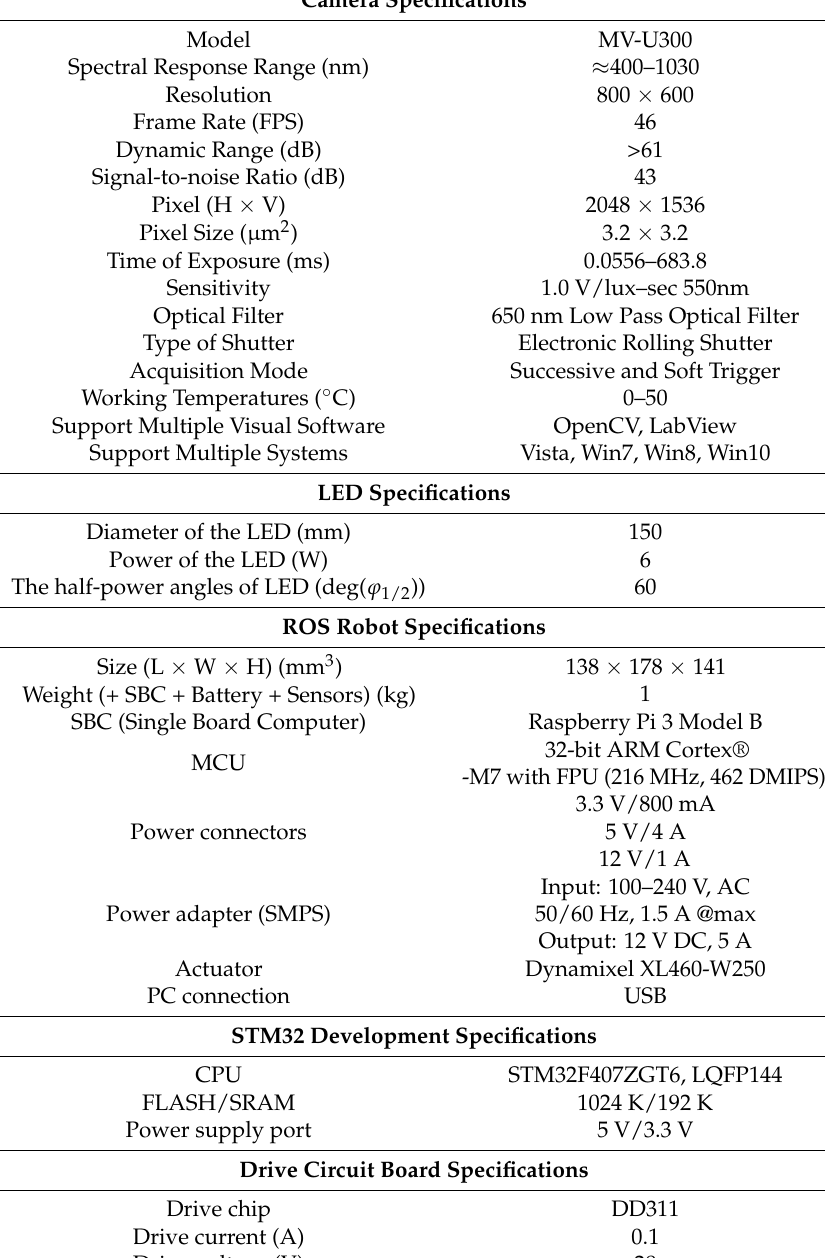
Table 1. Parameters of the experimental